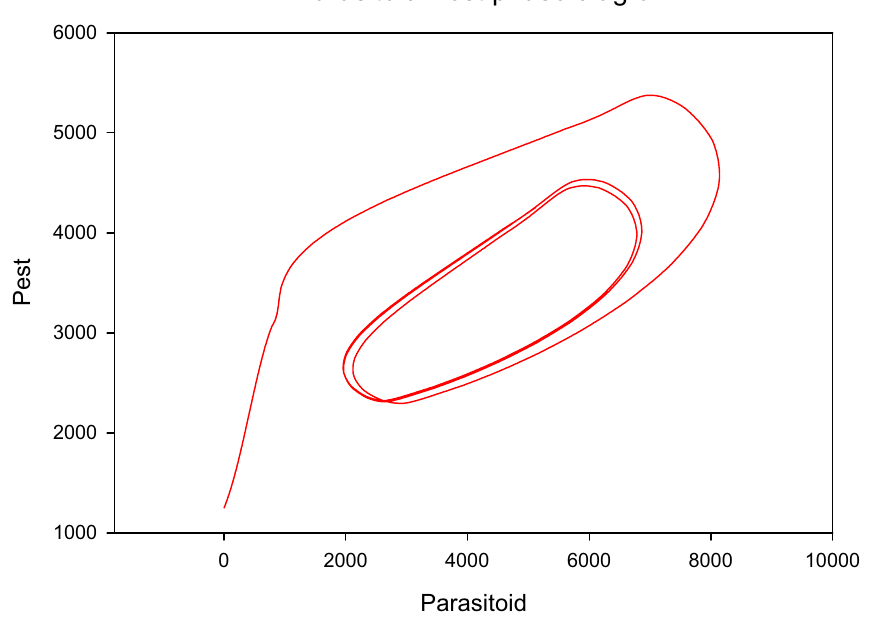
Figure 8. Parasitoid-host phase